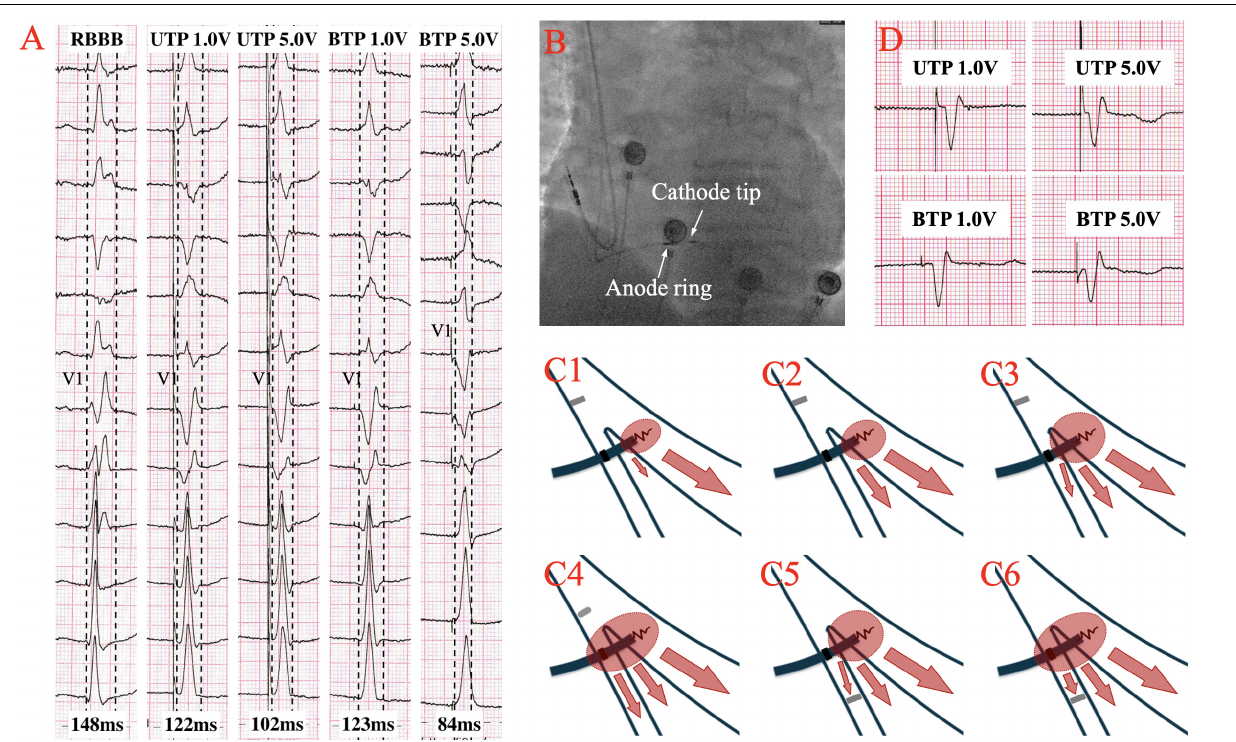
FIGURE 1 | (A) The QRS morphologies of intrinsic right bundle branch block (RBBB) under different pacing configurations of left bundle branch pacing (LBBP) at speed of 50 mm/s. QRS duration is shortened from intrinsic 148–122 ms at low output unipolar LBBP, and is further shortened to 102 ms at high output. The paced QRS morphology does not change significantly in unipolar pacing with low or high outputs, both presented a Qr pattern in lead V1. At low output bipolar LBBP, the paced QRS duration is 123 ms, which was similar to the performance at low output unipolar LBBP. However, at high output bipolar LBBP, the paced QRS duration is shortened to 84ms, and the paced QRS morphology changes significantly, showing that the r’ wave at the end of the QRS in lead V1 disappeared, suggesting the RV delay was compensated. (B) Sheath angiography of 3830 lead after LBBP completion. (C1–C6) Schematic diagram of different pacing modes of LBBP performed on RBBB. (C1–C3) Low output unipolar LBBP only captures the left bundle branch (LBB) and a small portion of the surrounding myocardium to partially shorten the RBBB. High-output unipolar LBBP captures LBB and more surrounding myocardium, further shortening RBBB, and may even overcome the resistivity of fibrous sheaths of longitudinal dissociation to completely correct RBBB. (C4) High output bipolar LBBP captures both LBB and RBB to completely correct RBBB. (C5,C6) When conduction delay occurs at the terminal branch of the RBB, neither the unipolar nor bipolar LBBP can bypass the blockage. (D) A case with no significant changes in QRS morphology and duration of RBBB under different LBBP modes, suggesting that RBB distal block might be involved.